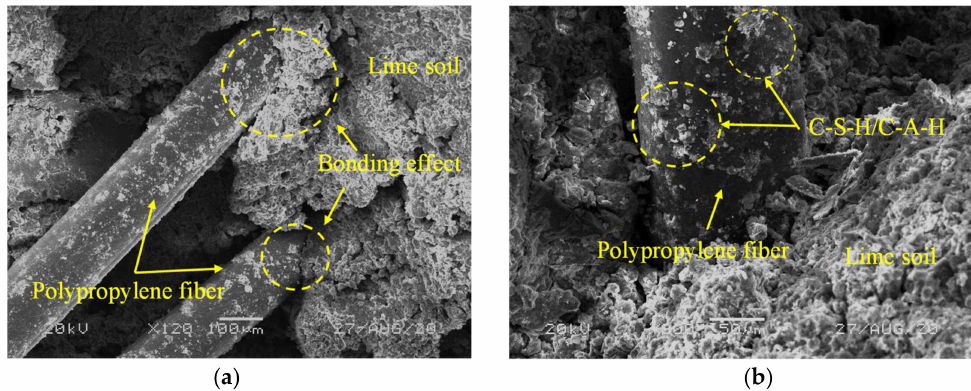
Figure 13. SEM images of FLS: ( a ) 120 × ; ( b ) 800 × .